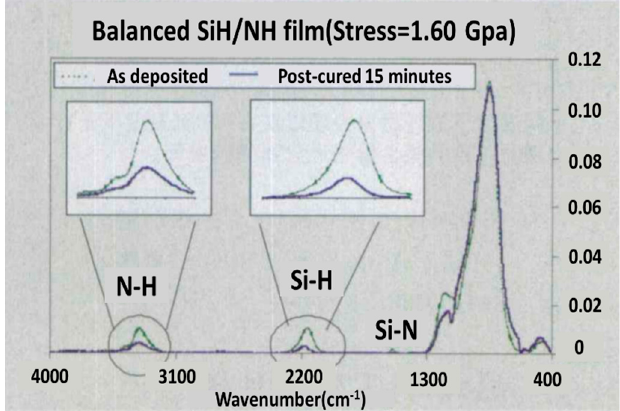
Figure 17. Tensile stress change with a UV Figure17. Tensile stress change with a UV cure.